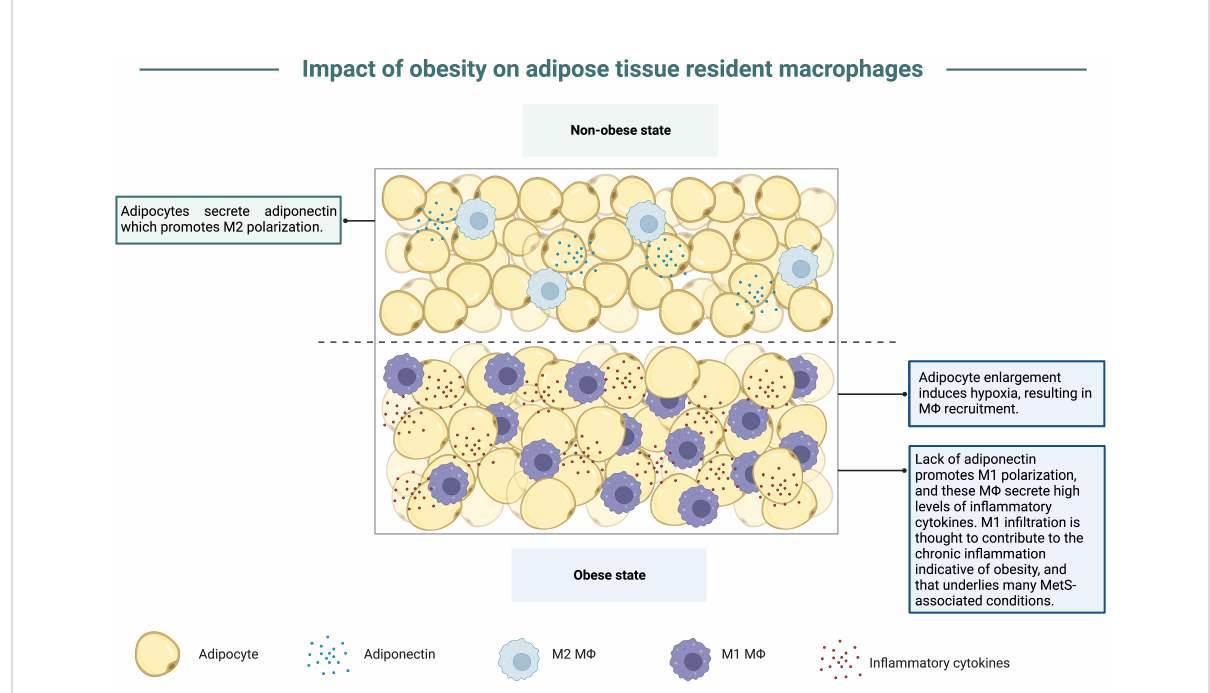
FIGURE 4 Obesity promotes accumulation of M1 macrophages. In the non-obese state, adipocytes secrete adiponectin, an adipokine that promotes macrophage polarization to the M2 phenotype. Within the obese state, adipocytes enlarge to store excess nutrients from overnutrition, which results in hypoxia and macrophage recruitment into adipose tissue. In the hypoxic state, less adiponectin is secreted, thus inducing macrophage polarization to the M1 phenotype, contributing to a state of chronic in fl ammation as these macrophages secrete high levels of in fl ammatory cytokines. This chronic in fl ammation is also believed to underlie and link the conditions that encompass